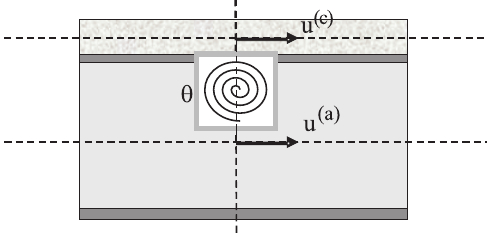
Fig. 1. Composite beam FE Fig. 3. Local buckling element with rotational